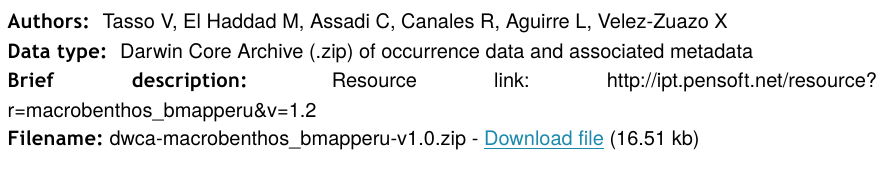
Suppl. material 2: Macrobenthos species ocurrence list